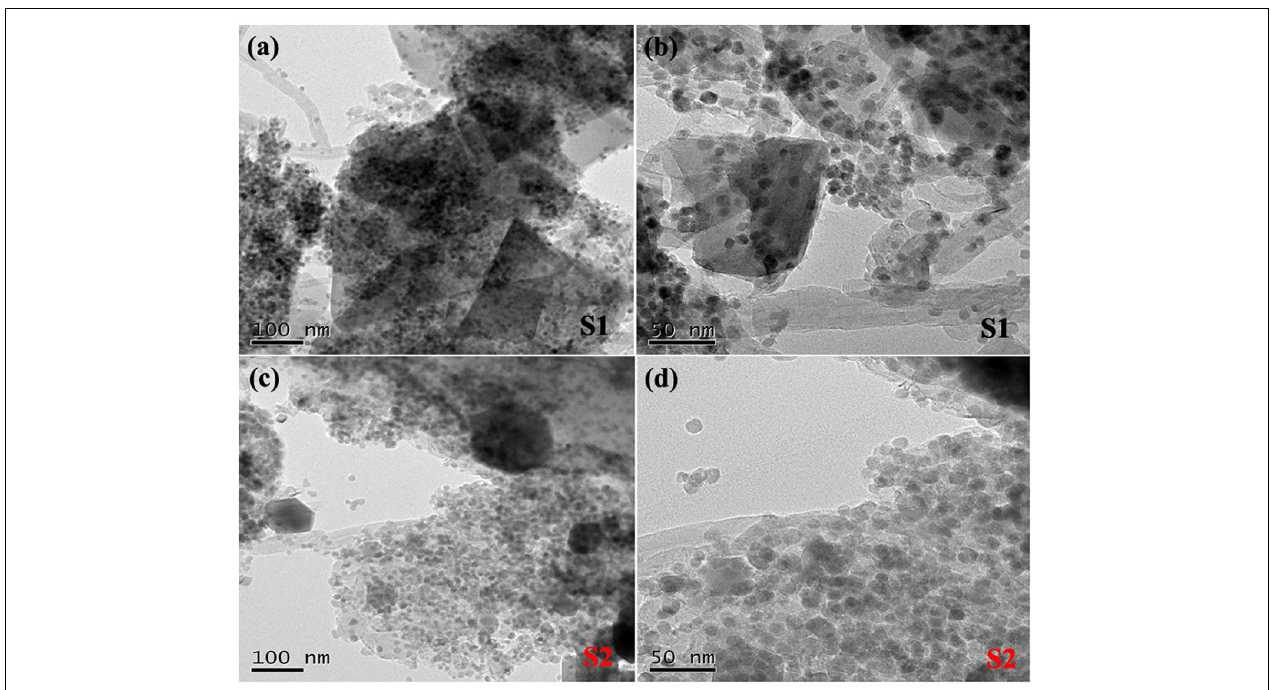
FIGURE 5 | TEM images of (a,b) S1, and (c,d) S2,